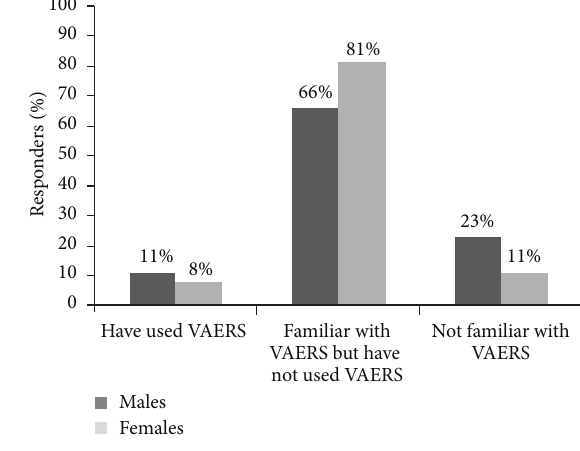
Figure 1: Familiarity with VAERS broken down by males and females (data not controlled for age) ( 𝜒 2 = 10.7 , 𝑃 = .005 ) (chi- square test for overall differences).